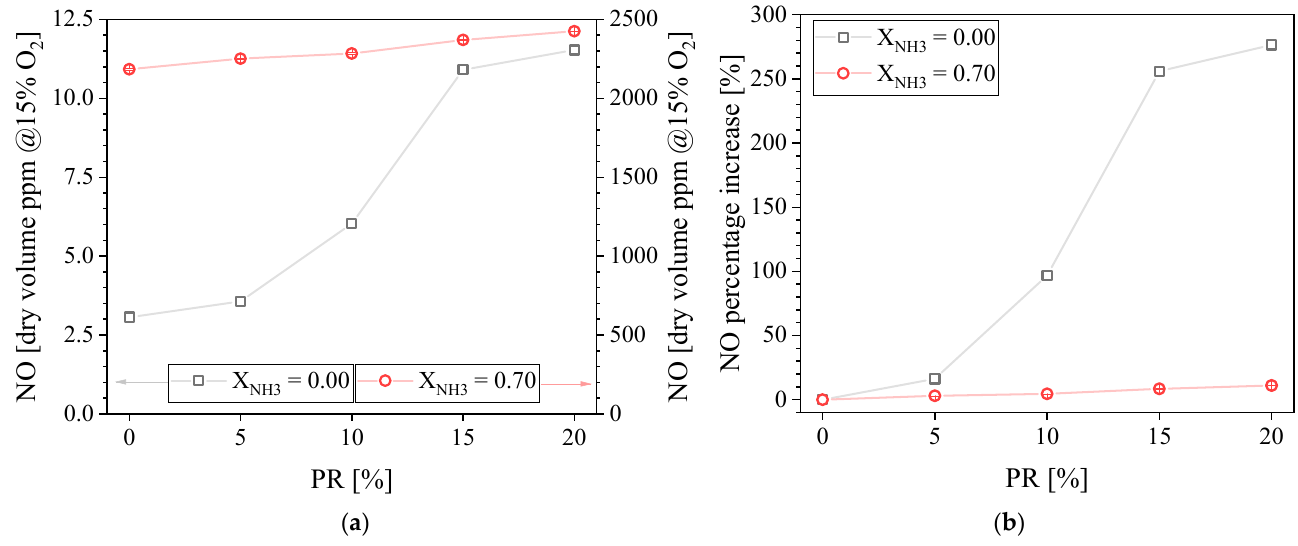
Figure 6. Measured NO concentration in the exhaust gases ( a ) and NO percentage of increase ( b ) as a function of the PR.